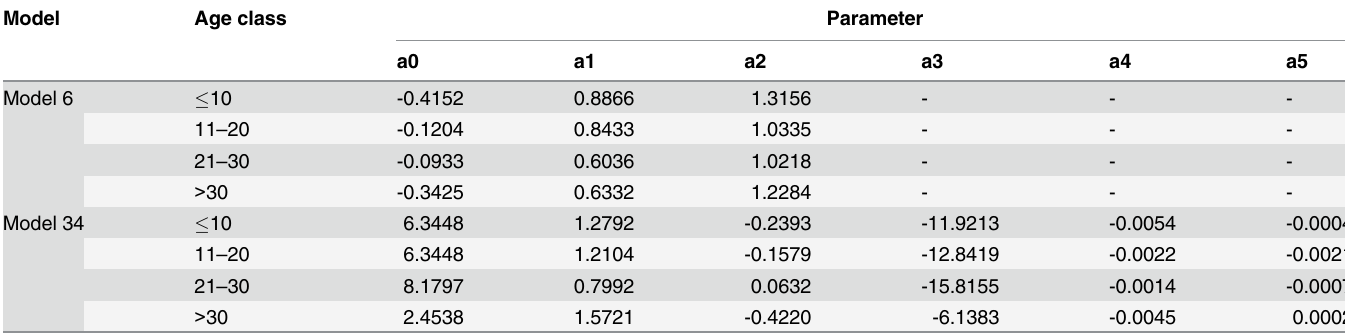
Table 7. Parameter estimates of the final models in different age classes.